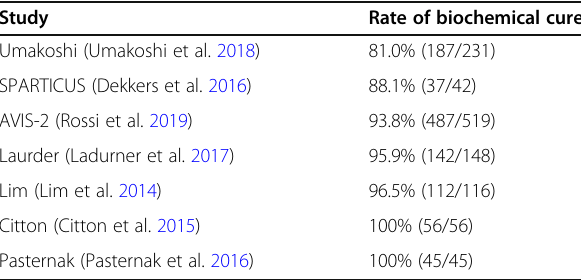
Table 3 Rate of biochemical PA cure cure after AVS guided adrenalectomy